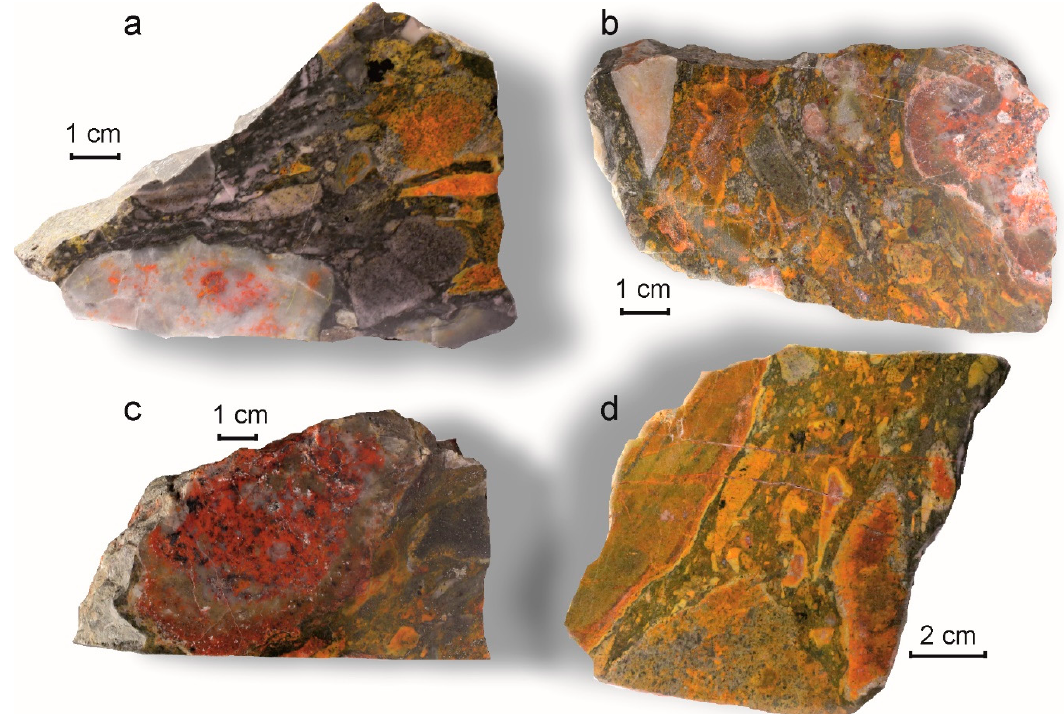
Figure 4. The varieties of gold ore breccias in the Vorontsovskoe deposit: ( a ) with a predominance of tuffstone and a small amount of orpiment-realgar cement in the fragments; ( b ) with a relatively equal amount of fragments of tuffstones (strongly altered) and marmorized limestones with a moderate amount of orpiment-realgar cement; ( c ) with equal amounts of fragments of tuffstones and marmorized limestones and a prevalence of realgar cement (black points are the accumulations of Tl and Hg sulfides and sulfosalts); ( d ) with a prevalence of metasomatically transformed tuffstones with a significant amount of orpiment-realgar cement.